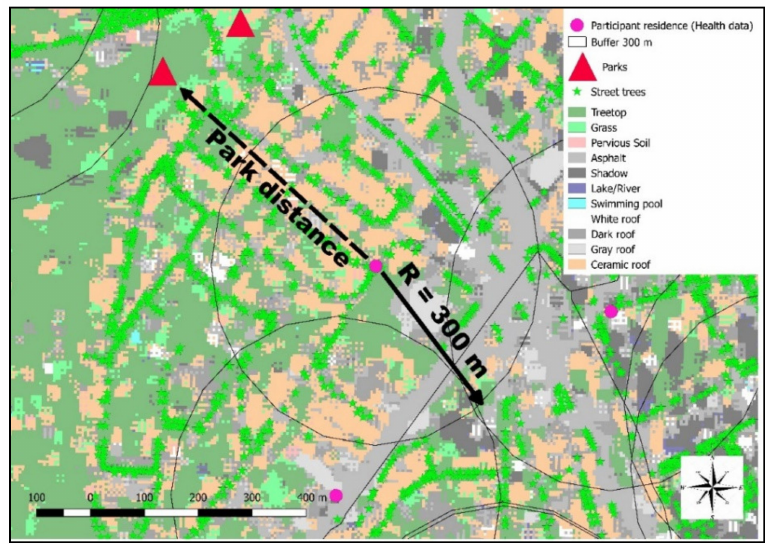
Figure 3. Exposure assessment metrics (Examples of the 300 m bu ff ers and Euclidean distance of